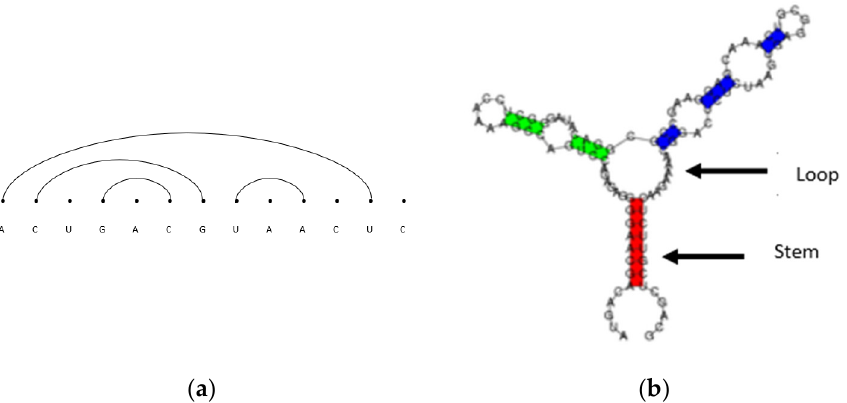
Figure 2. ( a ) An arc diagram representation of a longer RNA secondary structure; ( b ) a conventional diagram representation of RNA secondary structure.